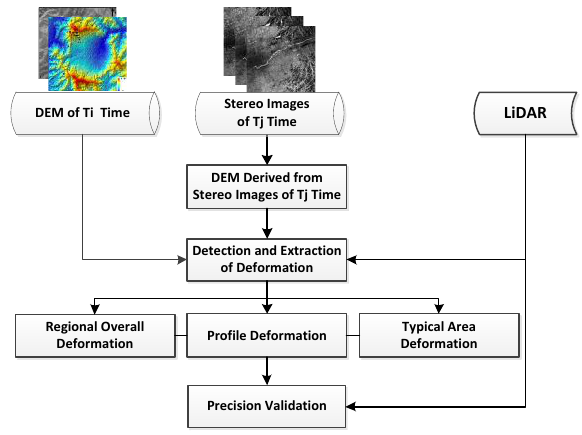
Figure 2 The main procedure of ground deformation extraction using visible images and liDAR